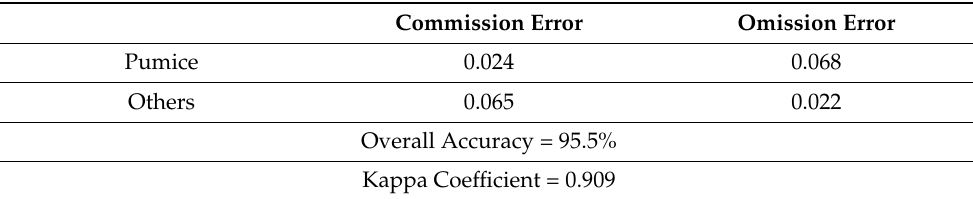
Table 2. Confusion matrix evaluation of extracted pumice rafts.